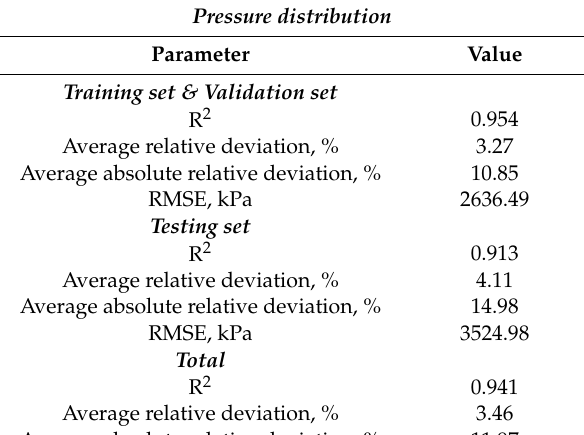
Table 5. The results of statistical error analysis performed in this study for the developed LSTM model.